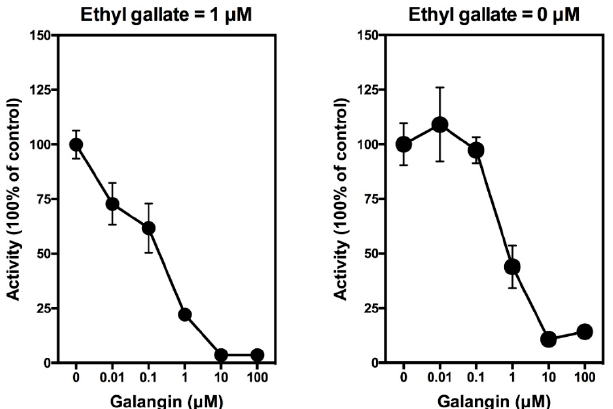
Figure 3. Effect of galangin on ethyl gallate-stimulated PGE 2 release from LPS-pretreated RAW264.7 cells. Cells were pretreated with 1 µg/mL of LPS for 2 h to induce COX-2 expression, and then, the culture media were removed and replaced with 300 µ L of serum-free medium containing 1 µ M ethyl gallate plus different concentrations (0.01, 0.1, 1, and 10 µ M) of galangin for another 2 h. The levels of PGE 2 were measured using an EIA kit (Cayman Chemical). The PGE 2 level in the control group is 1.5 ng/mL. Each point was the mean ± SD of triplet